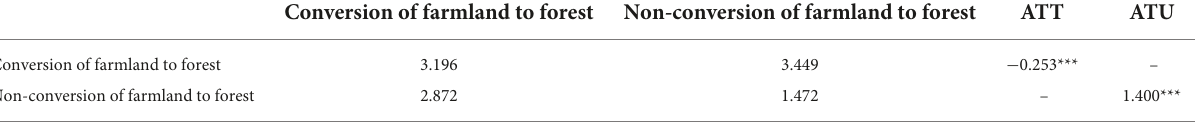
TABLE 4 Calculation of the treatment effect of the decision-making model of G.G.P. on the total family income. Farmer group Decision process Conversion of farmland to forest Non-conversion of farmland to forest Conversion of farmland to forest Non-conversion of farmland to